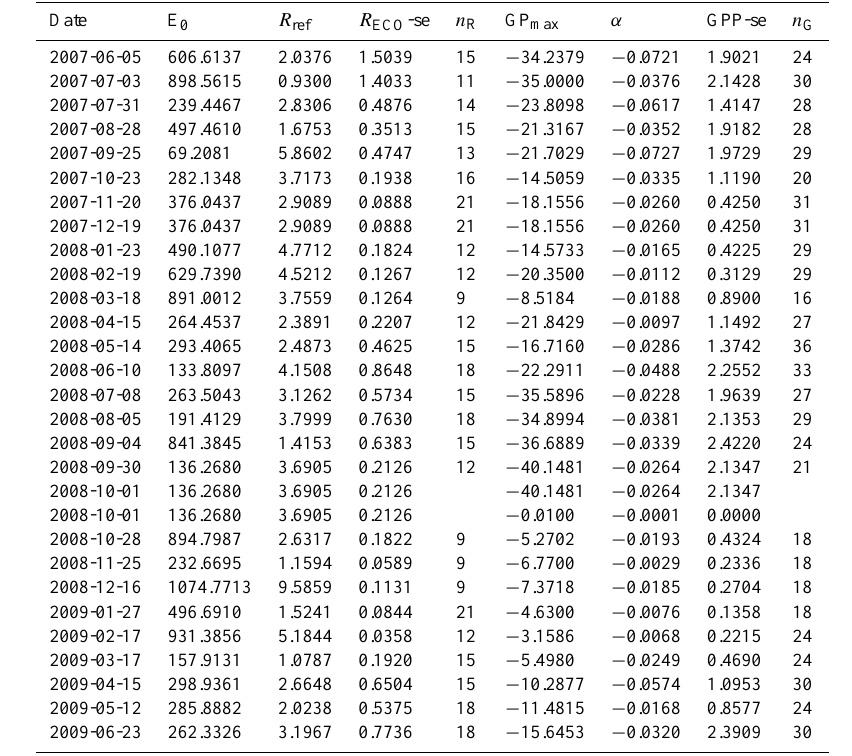
Table A2. Model parameters of the extensively used grassland site (GE). For explanation of the parameters see caption of Table